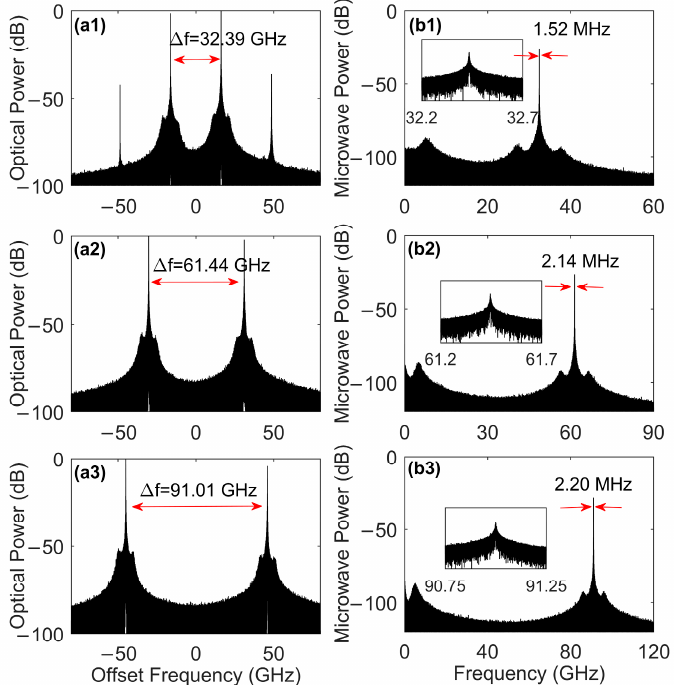
Figure 1. ( a1 – a3 ) Optical spectra and ( b1 – b3 ) RF spectra of the solitary optically pumped QD spin- VCSEL. ( a1 , b1 ) γ p = 30 π ns − 1 , ( a2 , b2 ) γ p = 60 π ns − 1 , and ( a3 , b3 ) γ p = 90 π ns − 1 . Other parameters are set as γ j = 10 ns − 1 , γ a = 0 ns − 1 , γ n = 1 ns − 1 , γ o = 400 ns − 1 , κ = 250 ns − 1 , α = 3, h = 1.1995, η = 4, and p =